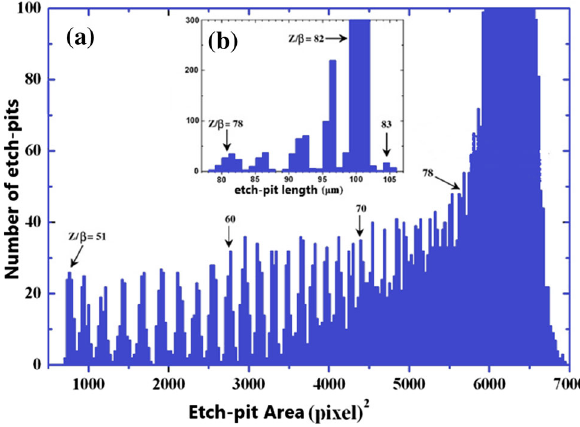
Fig. 9 Distribution of track surface areas in Makrofol exposed to 158 A GeV Pb 82 + and etched in soft conditions